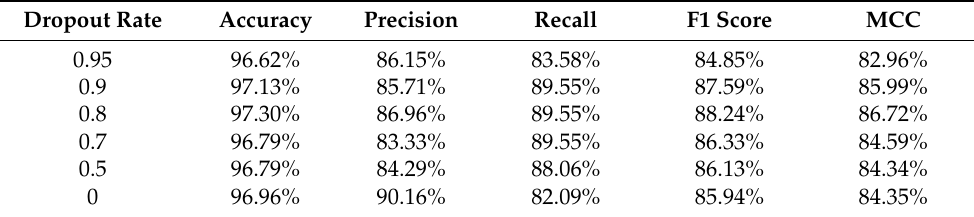
Table 5. Model performance for different dropout rates.